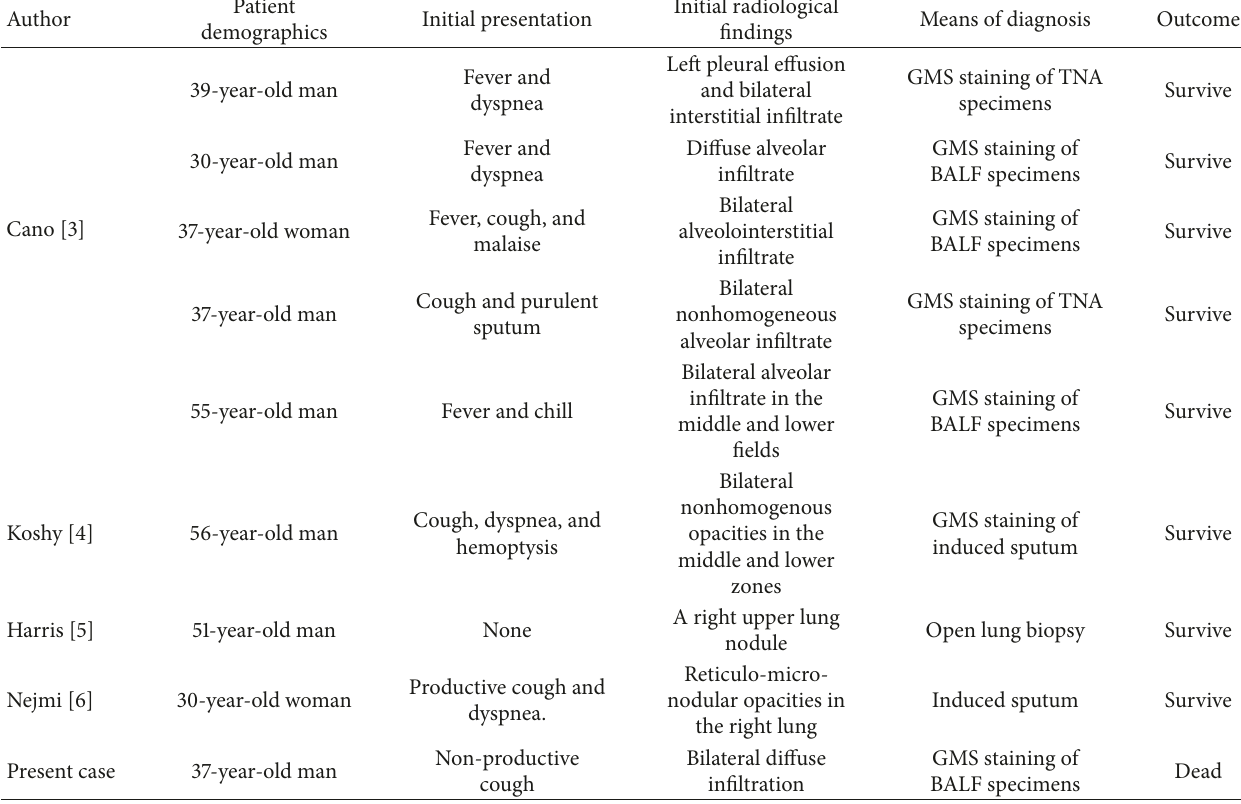
Table 1: Review of previously published